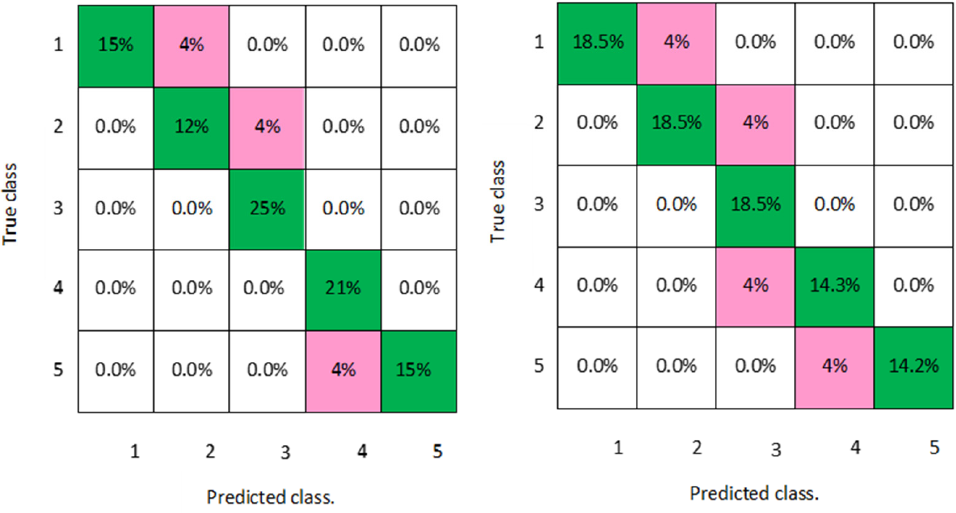
Figure 5. Cubic SVM model confusion matrixes for men and women data, respectively.